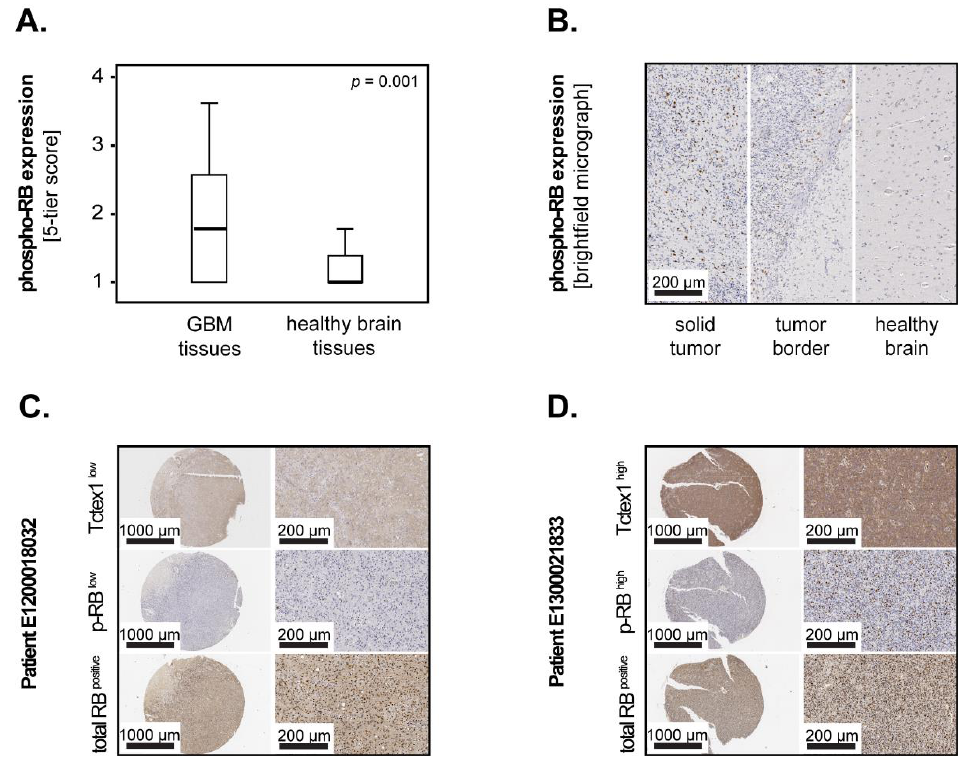
Figure 5. phospho-RB in GBM patients. ( A ) Expression of phospho-RB in matched pairs of GBM tissues and adjacent tumor-free brain tissues ( n = 14). The medians are shown as black lines, and the percentiles (25th and 75th) as vertical boxes with error bars. Statistical analysis was performed with the Wilcoxon test. ( B ) Representative micrographs showing the expression of phospho-RB in the solid tumor area (left panel), tumor border area (middle panel) and adjacent tumor-free tissue area (right panel), respectively. Representative micrographs showing ( C ) synchronous low levels and ( D ) synchronous high levels of Tctex1 and phospho-RB in GBM tissues. The corresponding levels of total RB are shown in the lower panels.